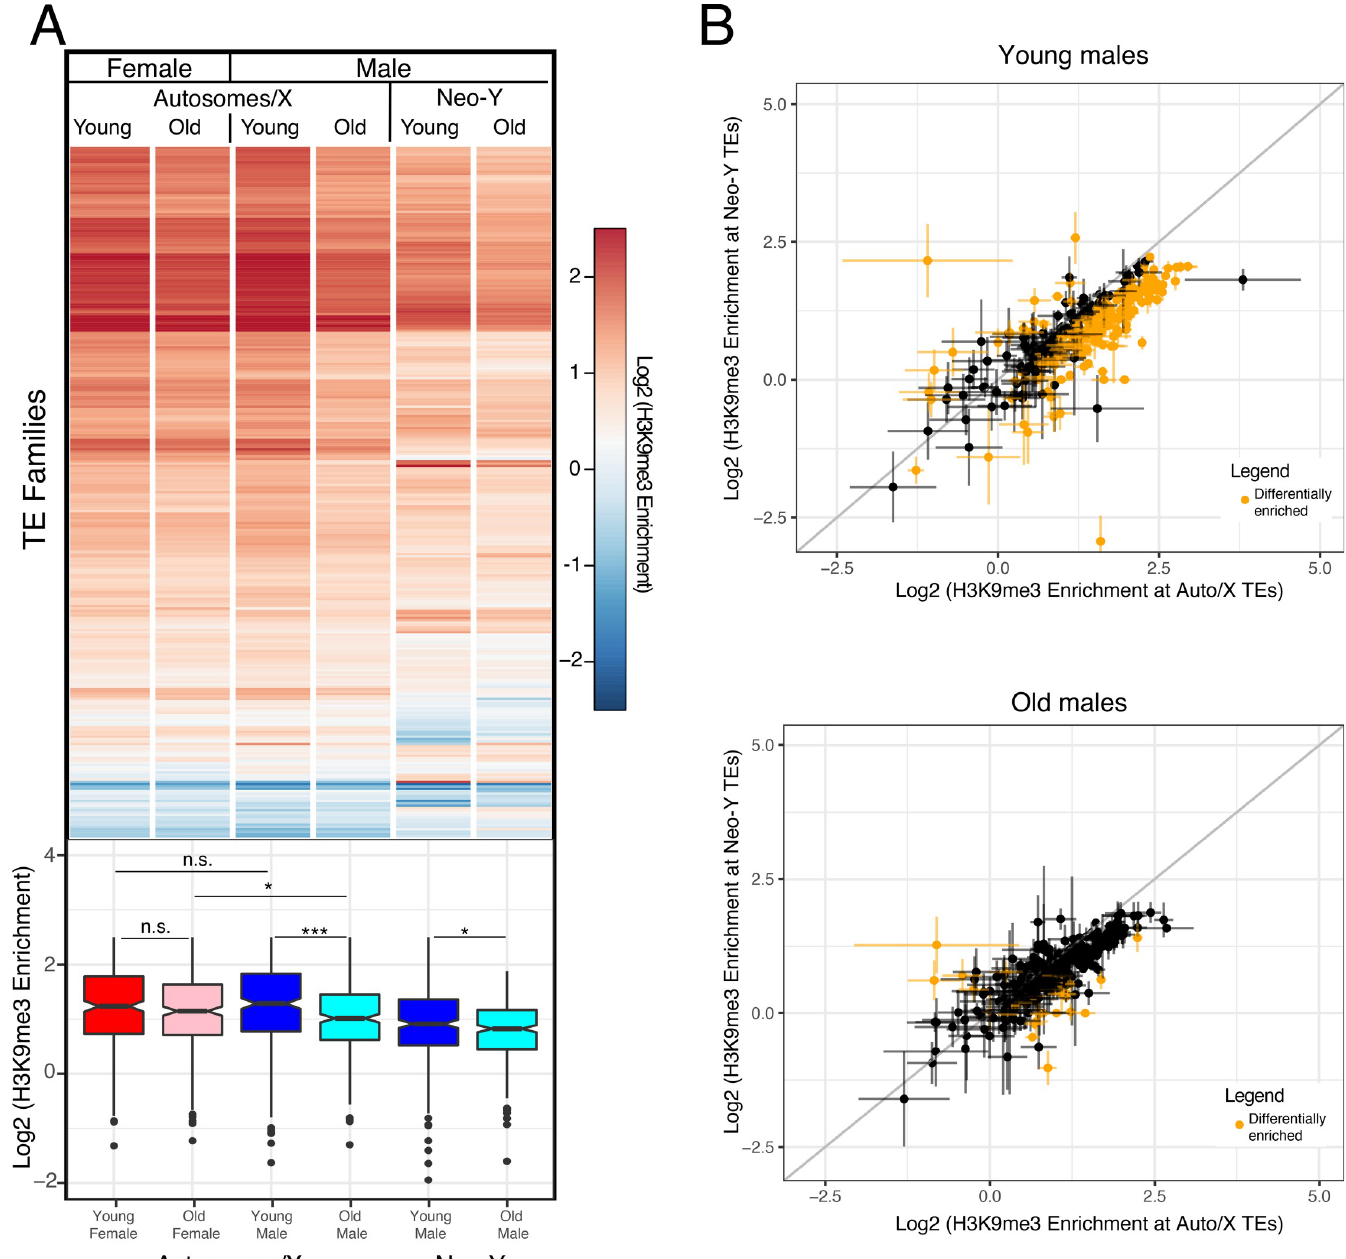
Fig 5. Heterochromatin enrichment at TEs across sex, time and chromosomes. Shown is enrichment of H3K9me3 at different repeat families for young and old females and males. A. Log2 H3K9me3 enrichment of all transposable elements (from [55]) in young (5–9 day) and old (80–98 day) male and female MSH22, averaged across 4 replicates for Young/Old Females and Young Males and across 3 replicates for Old Males. H3K9me3 enrichment in males is separated by autosomes/X and neo- Y. Boxplots below with significance values calculated using the Wilcoxon test ( � p < 0.05, �� p < 0.01, ��� p < 1e-5). B. Log2(H3K9me3 enrichment) differences between TEs found on the Autosomes/X and the neo-Y for young (top) and old (bottom) males. Data represents averages of 4 replicates for Young/Old Females and Young Males and of 3 replicates for Old Males. The bars denote standard error. Data highlighted in yellow are TEs that show significant differences in H3K9me3 enrichment on autosomes/X and neo-Y (p < 0.05, two-tailed Student’s t-test).